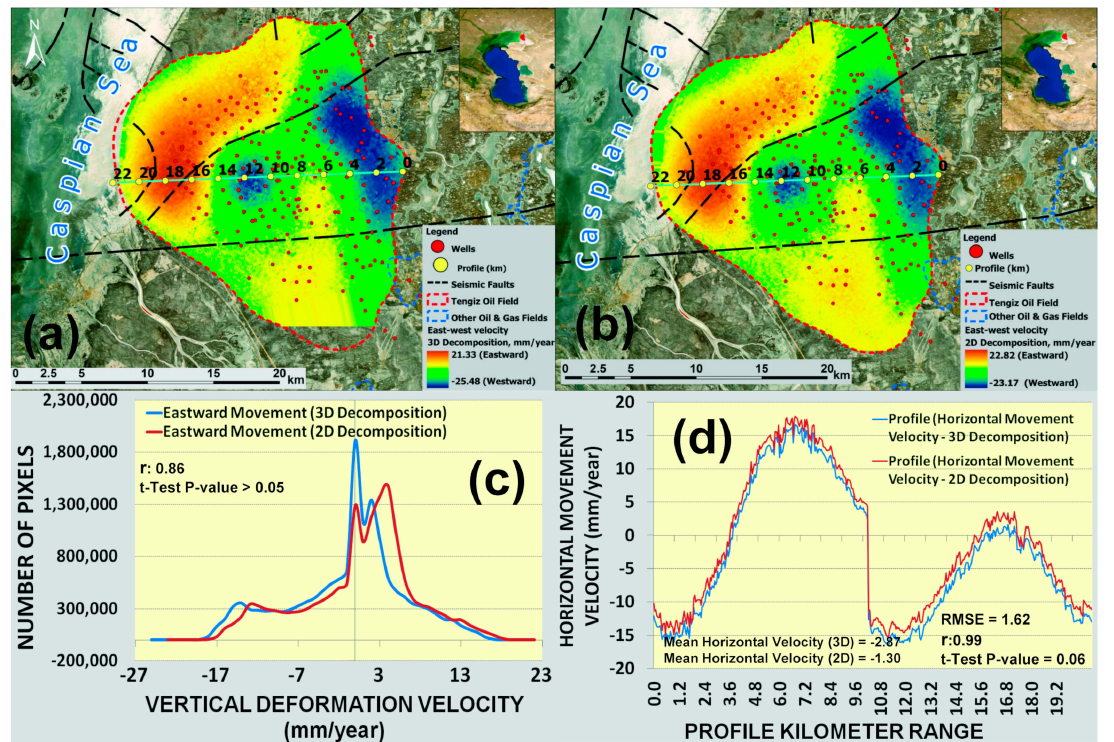
Figure 8. East-west movement velocity derived from: ( a ) 3D decomposition of 2 ascending and 1 descending LOS measurements; ( b ) 2D decomposition of 1 ascending and 1 descending LOS measurements; ( c ) histogram of east-west movement velocities derived from 3D and 2D decompositions; ( d ) profiles of east-west movement velocities derived from 3D and 2D